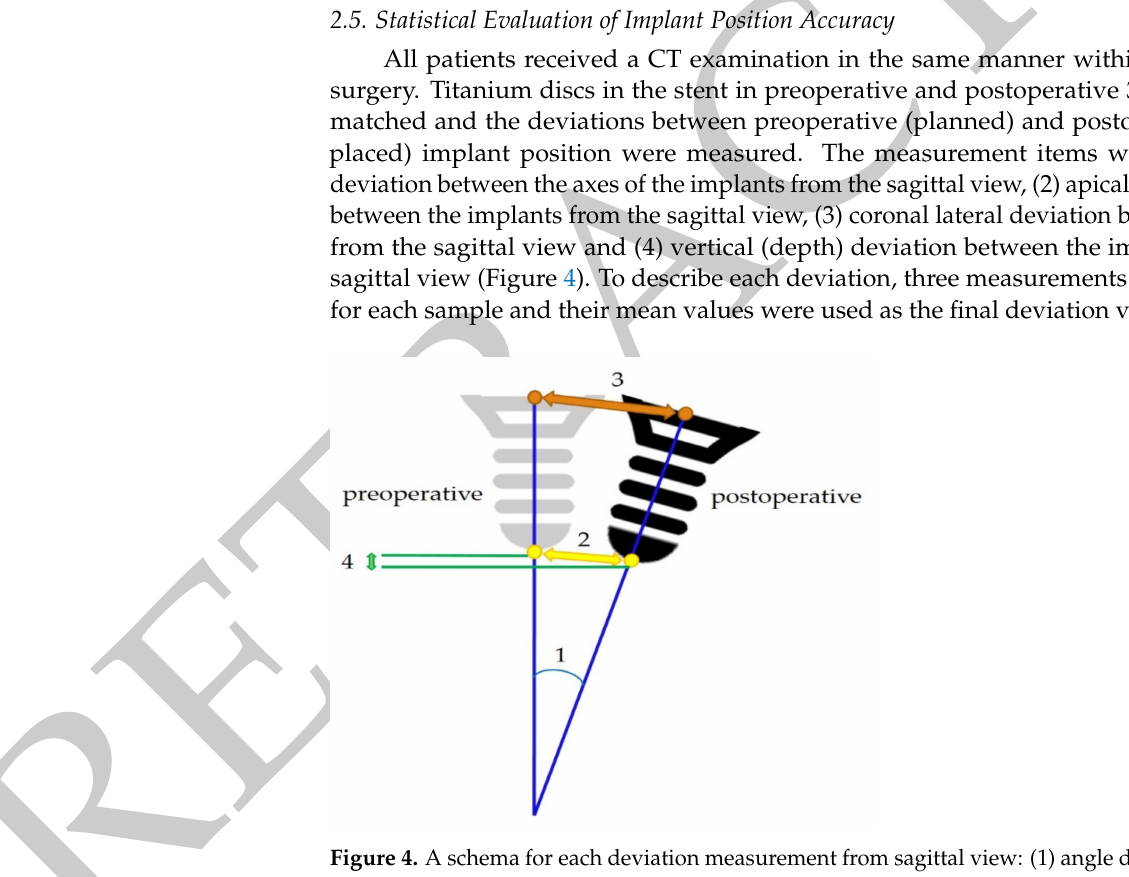
Figure 3. Implant placement using the present dynamic navigation system.